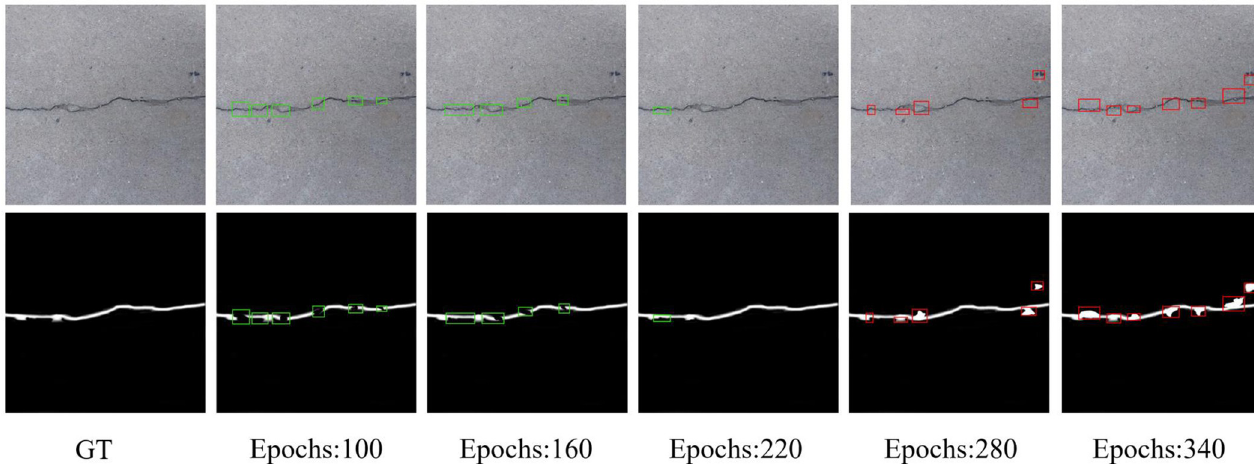
Fig 9. Comparison of output results at different epochs. The green boxes locate the missing detection parts of the detection results and the red boxes locate the false detection parts of the detection results.